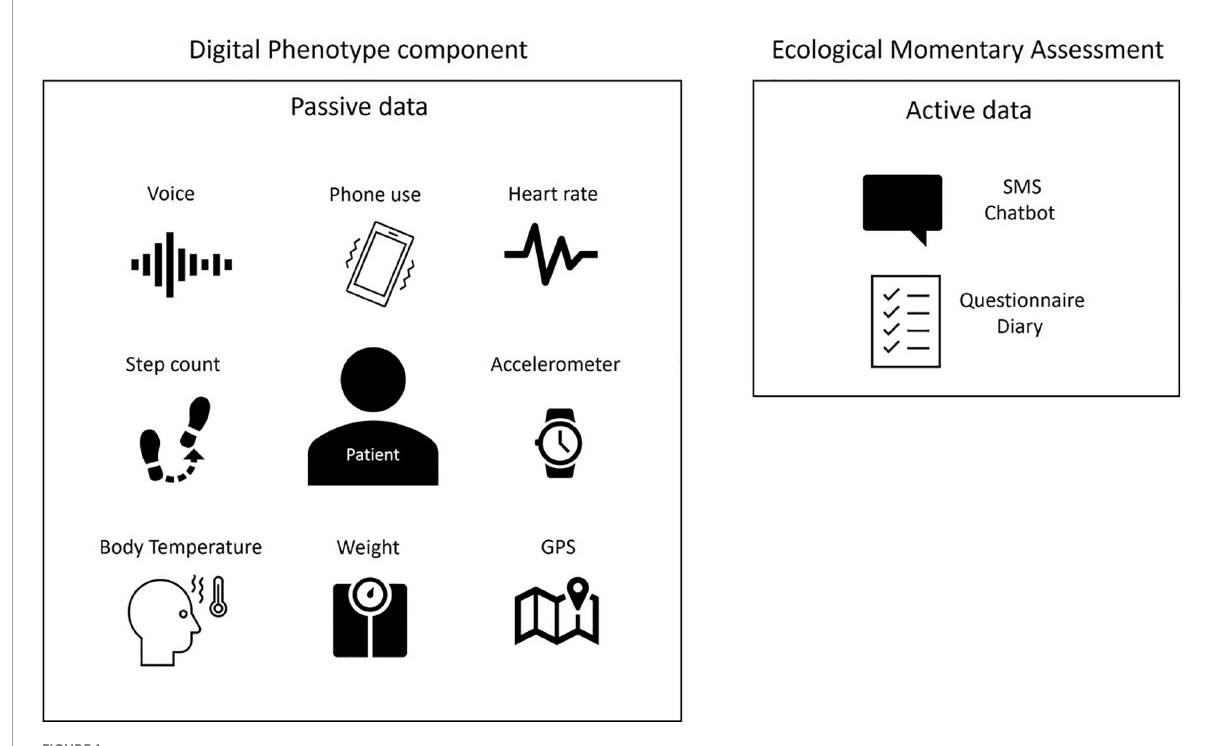
FIGURE1 The concept of digital phenotype for mood disorders as opposed to